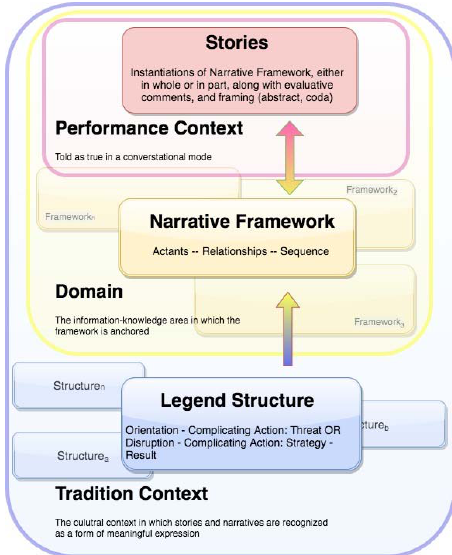
Figure 2. A simple generative model of legend, showing the relationship between structure, narrative framework, and story, as well as the relationship between tradition, domain and performance context. The blue represents macroscale, yellow mesoscale, and red microscale